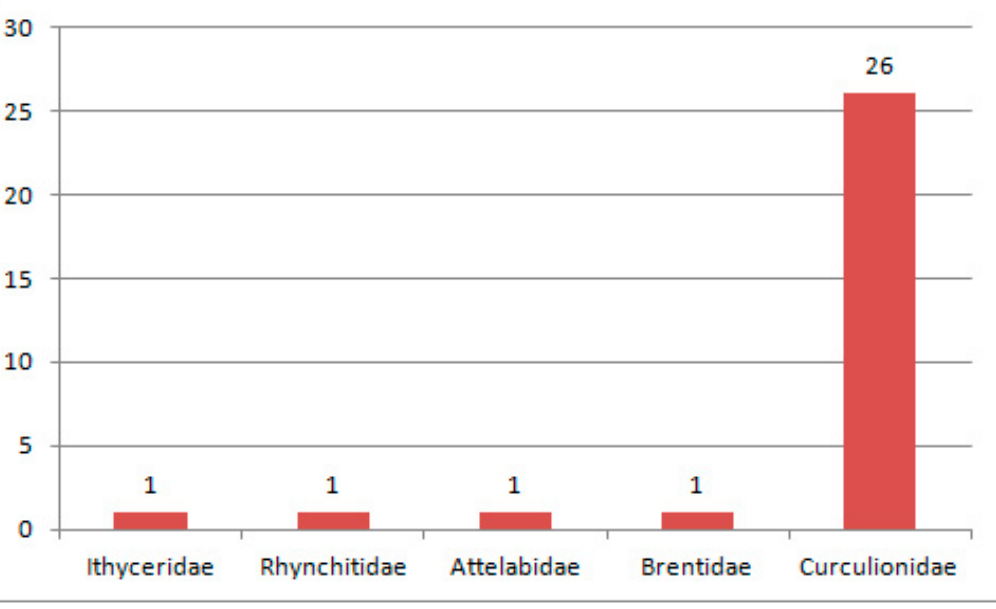
Figure 3. Composition of species of Curculionoidea in the Paleocene fauna.